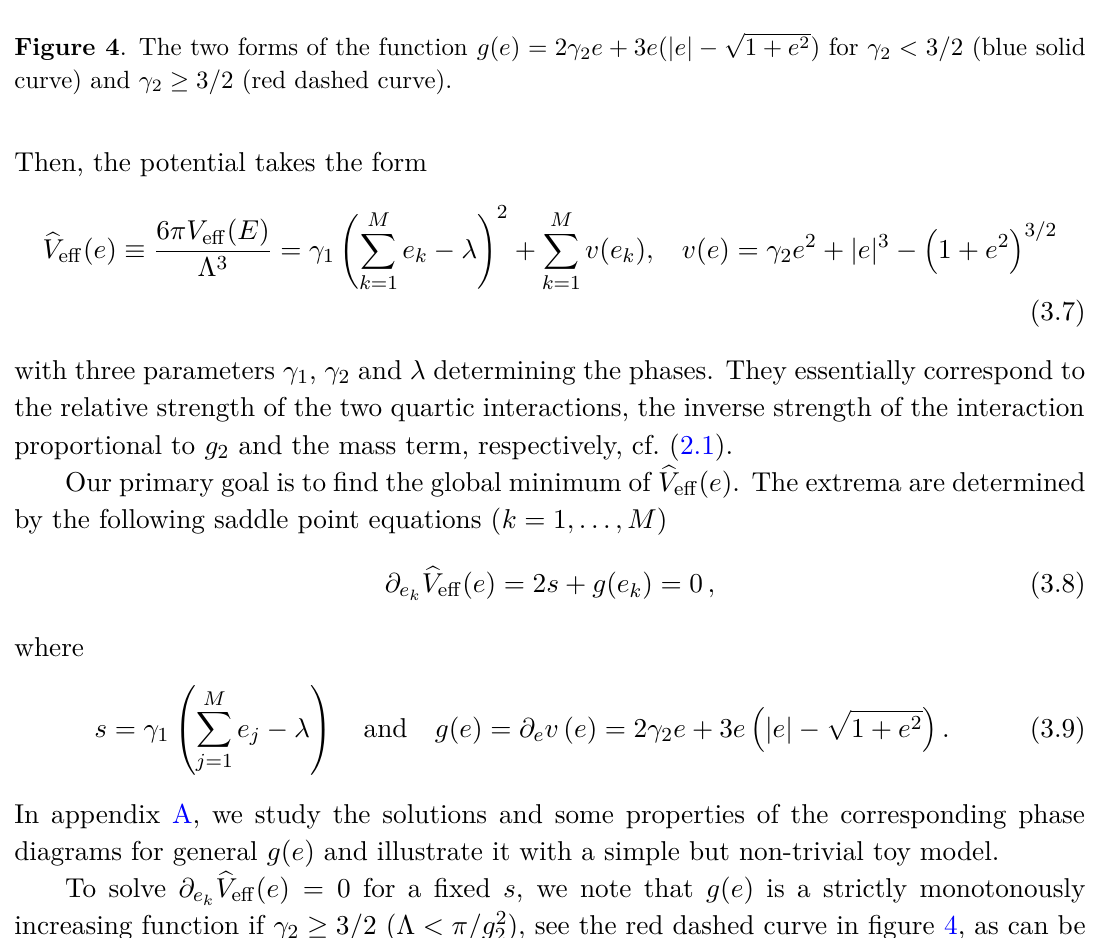
√ 1 + e 2 ) for γ 2 < 3 / 2 (blue solid